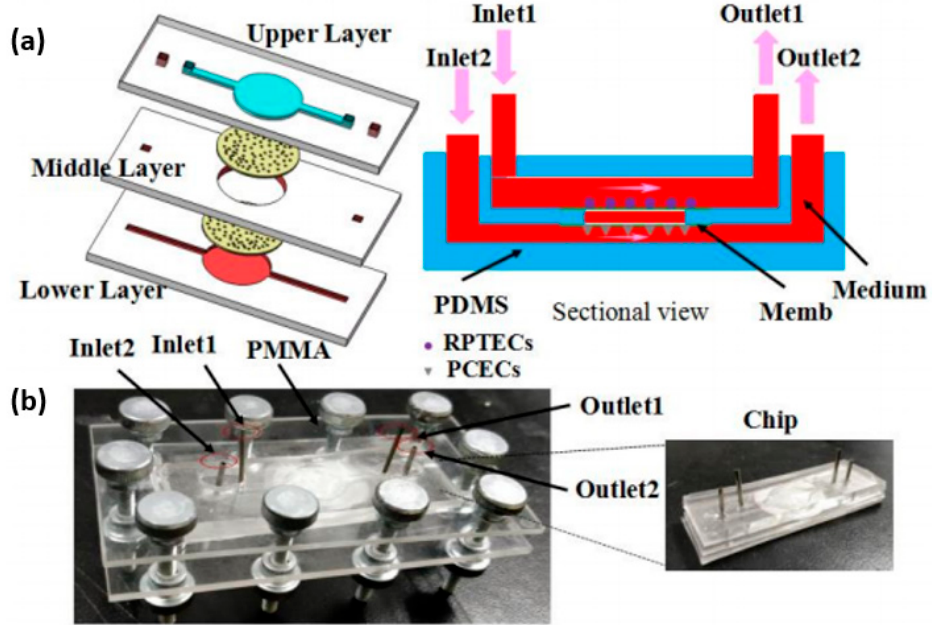
Figure 5. Kidney-on-a-chip microfluidic device. ( a ) Schematic diagram of the chip containing renal proximal tubular epithelial cells (RPTECs) and peritubular capillary endothelial cells (PCECs), and its sectional view and ( b ) current assembled chip. Reprinted from an open-access source [103].